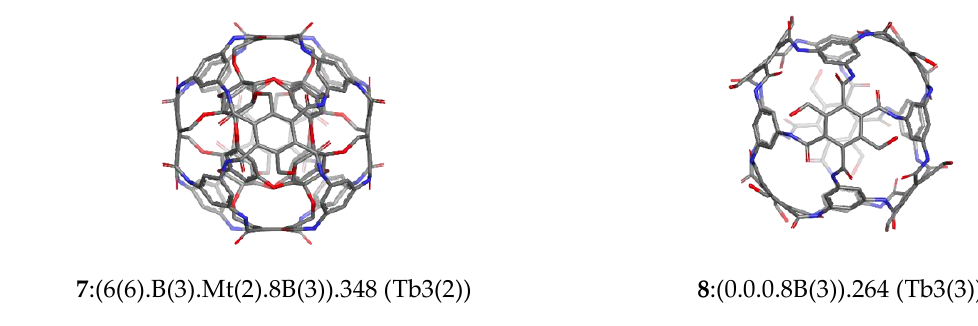
Figure 6. Cube rhombellane structures (Table 3).